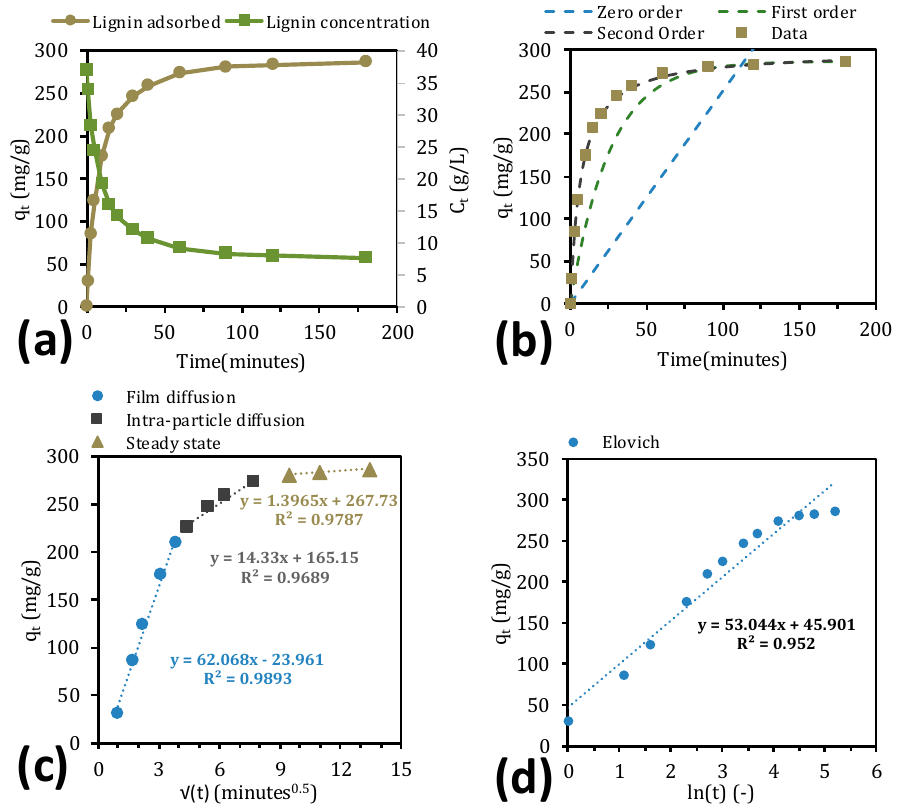
Figure 3. Lignin adsorption and concentration vs. time ( a ) and the resulting fit of the kinetic models to the data ( b – d